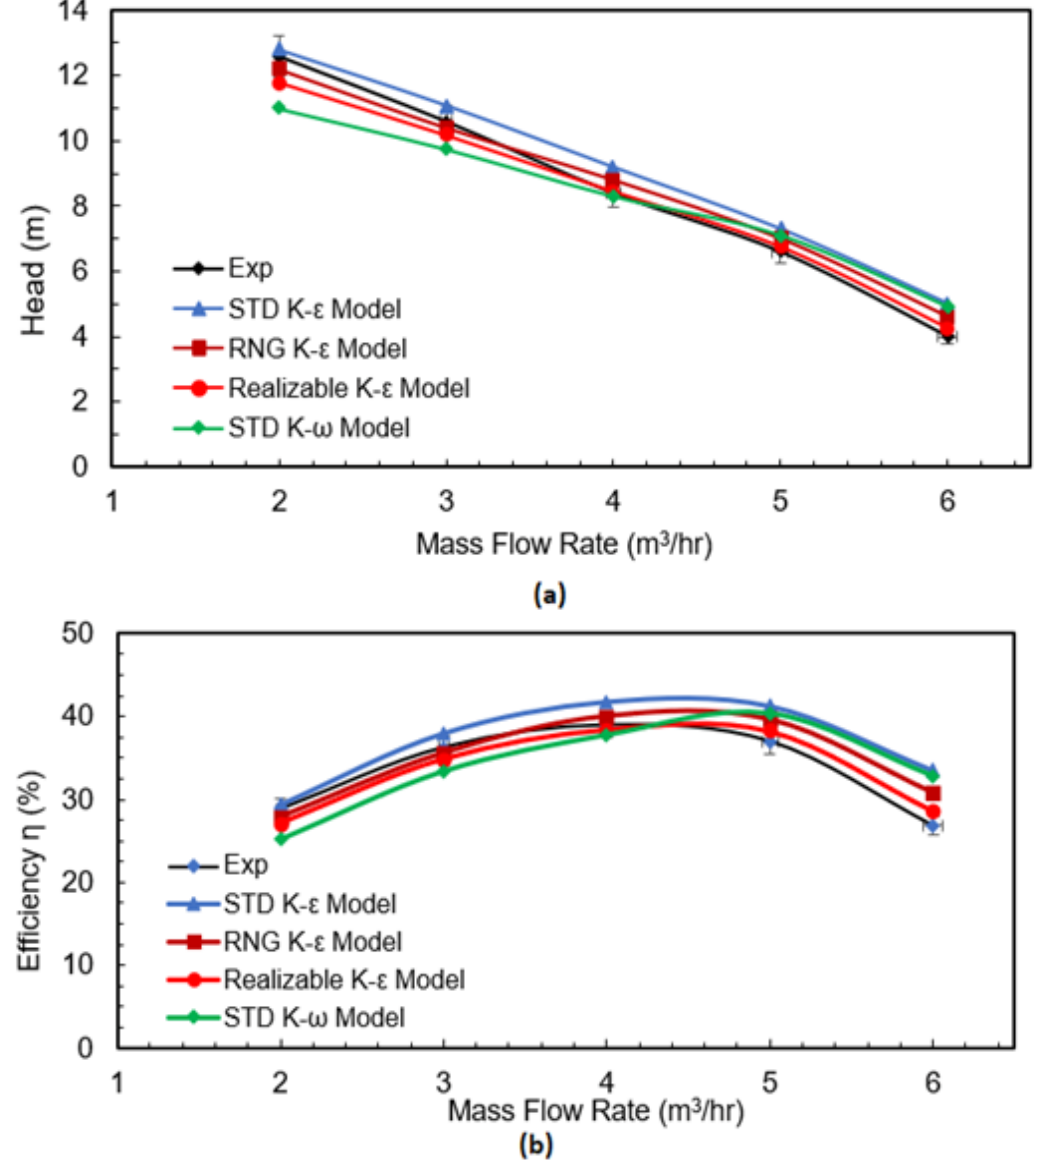
Figure 9. Comparison of the hydraulic performance between experiments and numerical simulation ( a ) Head -flow rate ( b ) Efficiency-flow rate.